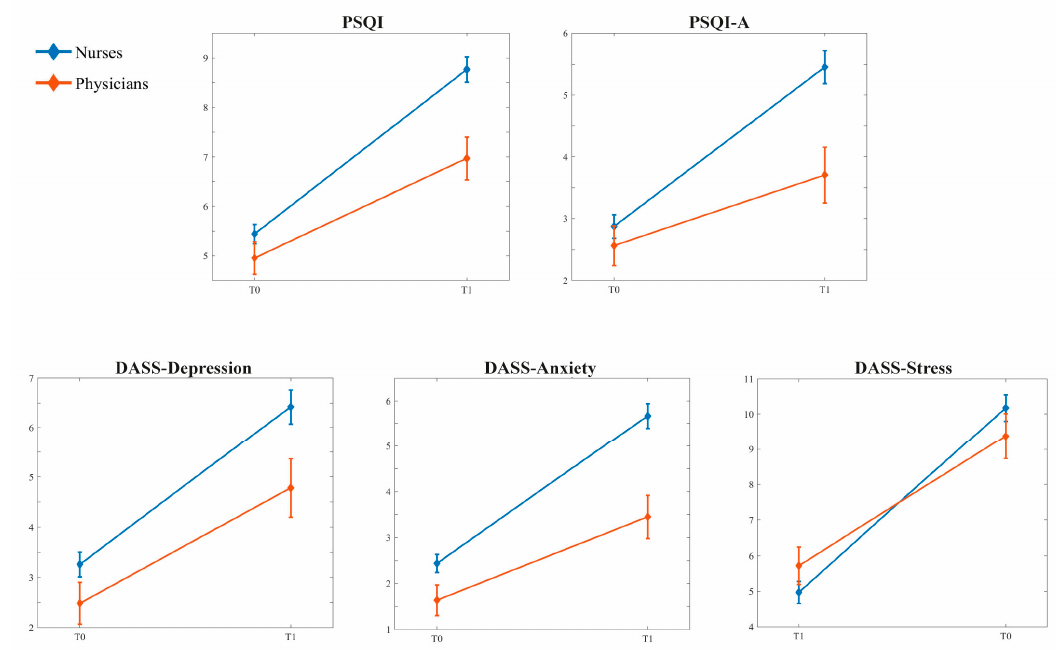
Figure 2. Mean (and SE) across the two time periods (T0: before the pandemic; T1: current period) in the two groups of HCWs (212 nurses and 75 physicians) for the following variables: total scores of Pittsburgh Sleep Quality Index (PSQI), total scores Pittsburgh Sleep Quality Index-Addendum (PSQI-A), scores on each scale of Depression Anxiety Stress Scale